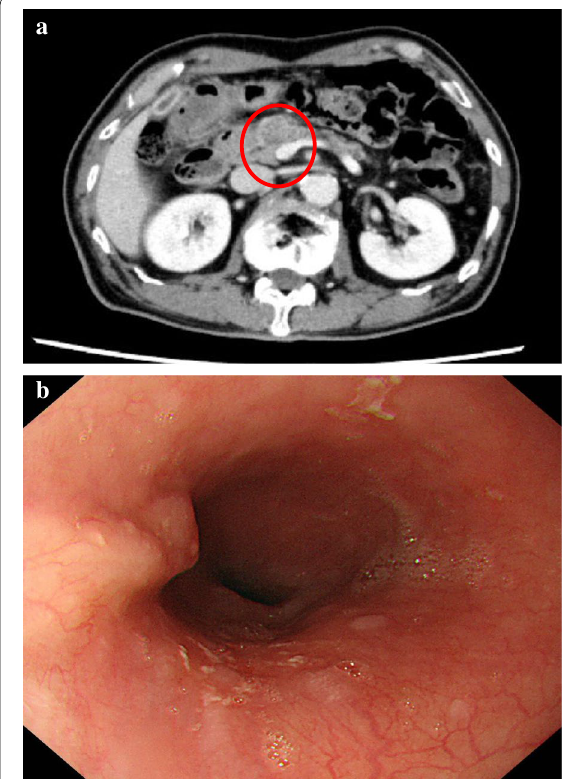
Fig. 5 Therapeutic assessments after neoadjuvant chemotherapy for treatment of pancreatic cancer. a Computed tomography showed regression of the pancreatic tumor (red circle) in size from 26 to 18 mm after neoadjuvant chemotherapy. b The regression of esophageal cancer was endoscopically verified for its invasion into the muscularis mucosae after neoadjuvant chemotherapy for treatment of pancreatic